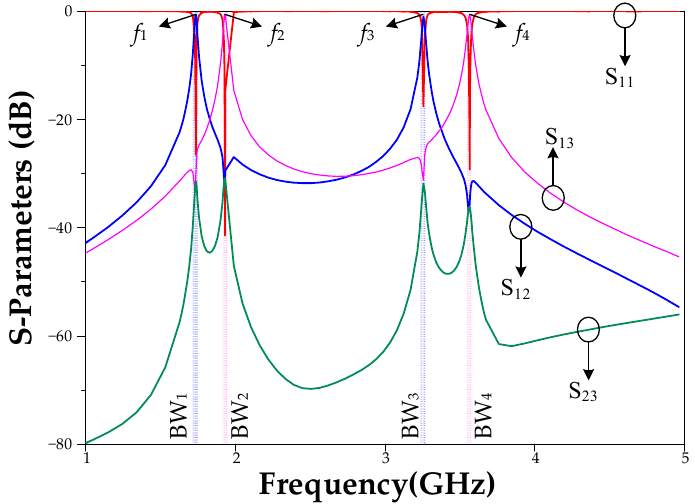
Figure 12. The S-parameter of the proposed diplexer with four center frequencies of 1700 MHz, 1900 MHz, 3300 MHz, and 3600 MHz.